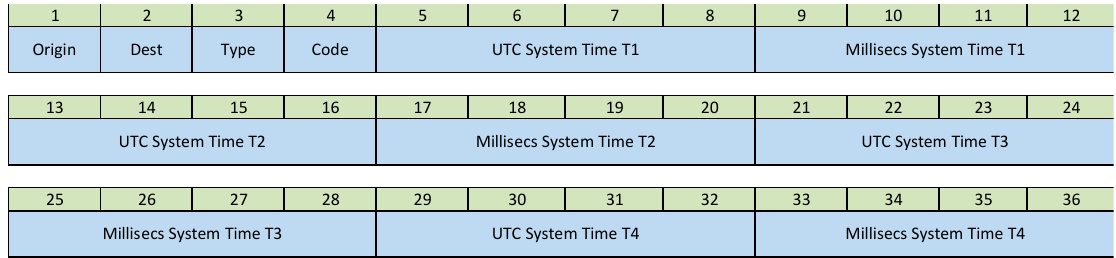
Figure 8. Structure of the synchronization (SYNC CLK) messages. In type 9 messages, the TimeStamps of the time of sending each phase are added to the frames until the four TimeStamps required for the calculations are completed. These four fields are the TimeStamp value in UTC format and in milliseconds. Each of them occupies 4 bytes. The third type of message, SYNC CLK Return, is added to return the complete time sequence to the Node so that it can perform the calculations by itself and thus be able to adjust the local time. The delay and time drift respecting the RPI Server time are calculated by equation [1], the meaning of whose variables are in Figure 9. For the example shown in the Figure 9, it gives us values of delayT = 60 ms and drift = − 20 ms, that means that the Node has a delay of 20 ms so it will have to advance its Timer about 20 ms.